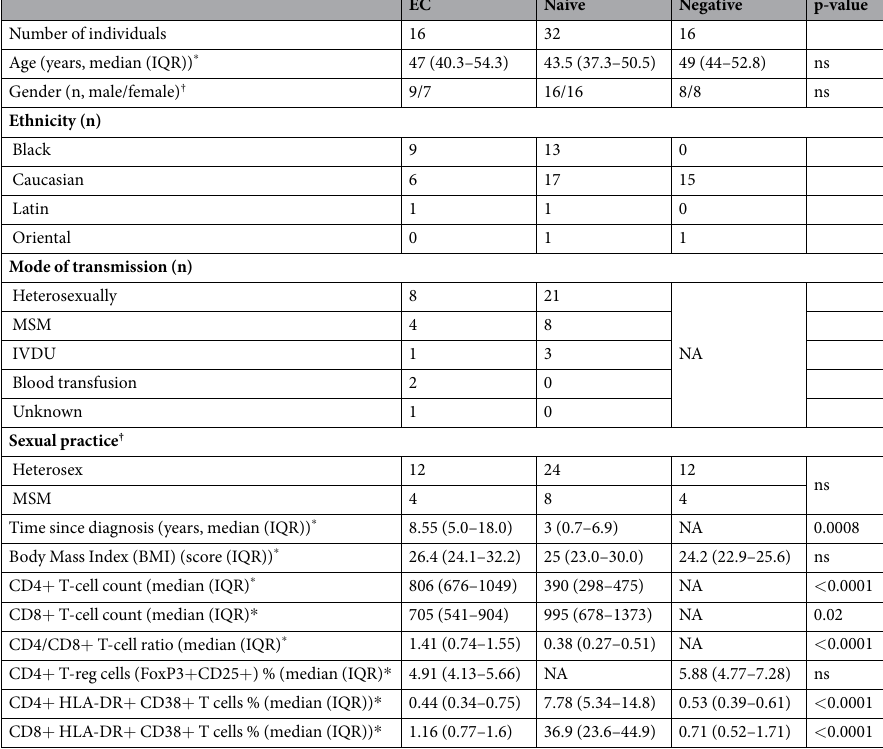
Table 1. Cohort demographics and cellular immune activation markers at baseline. EC = elite controllers. Naive = viral progressors. Negative = negative controls. * Kruskal-Wallis test was used for comparison between three groups, and Dunn’s Multiple Comparison Test was adapted for “post hoc” testing. Mann-Whitney was applied for comparisons between two groups. † Chi-square test was applied. NA (not available). ns (non significant) indicates p-value >